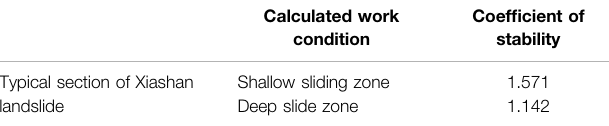
TABLE 1 | Calculation results of landslide stability.